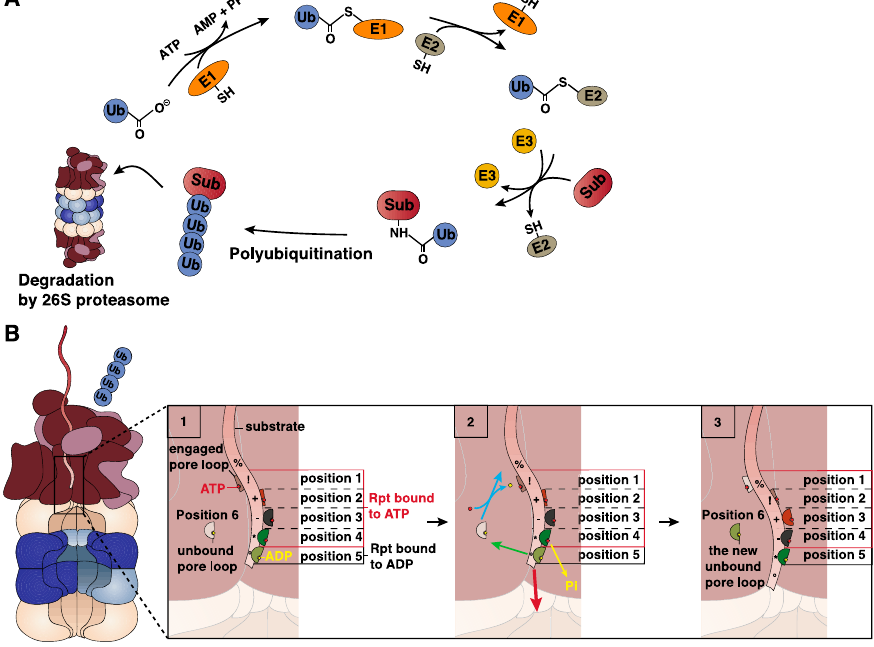
Figure 4. ATP- and ubiquitin-dependent degradation of proteins by the 26S proteasome. ( A ) Ubiquitin conjugation. Ubiquitin (Ub) conjugation requires the activity of three enzymes. E1 (a ubiquitin-activating enzyme) catalyses the ATP-dependent activation of the Ub moiety and its transfer to a conserved active cysteine on E1. Ub is then transferred to an active cysteine on E2 (a ubiquitin-conjugating enzyme). The transfer of the Ub moiety to the substrate requires the activity of an E3 enzyme (a ubiquitin ligase) that can interact with both E2 and the substrate. The resulting product is a protein–ubiquitin conjugate. Finally, the ubiquitin moiety already conjugated to the protein can undergo polymerization by the addition of ubiquitin moieties, forming a suitable tag that allows the targeting of the protein substrate for 26S proteasomal degradation. ( B ) Translocation of the protein substrate into the 26S proteasome. (1) Five of the six pore loops (presented here as half-circles) found in the AAA+ motor of the 19S regulatory particle align in a spiral staircase configuration entrapping the substrate. The four Rpt subunits with the pore loops at the uppermost positions are bound to an ATP molecule (red circle), and the Rpt subunit with the pore loop at the bottom position (position 5) is bound to an ADP molecule (yellow circle). The unbound pore loop occupies position 6 and is not bound to the substrate. (2) First, the Rpt subunit at position 4 hydrolyses the ATP molecule (yellow arrow), and the unbound Rpt subunit binds an ATP molecule. The newly formed Rpt-ATP subunit binds the substrate at the uppermost position as indicated by the light blue arrow, while the pore loop at position 5 disengages the substrate as indicated by the green arrow. Finally, the four Rpt subunits at positions 1–4, which are bound to the protein substrate, move downward, resulting in the translocation of the substrate (red arrow). (3) Following all these changes, the pore loop that was at position 6 occupies the uppermost position (position 1), the pore loop at position 3 occupies the penultimate position (position 4), the pore loop at position 4 occupies the bottom position (position 5), and the Rpt subunit with a pore loop at position 5 dissociates and becomes the new free pore loop at position 6 [104]. Symbols (%, !, +, -, * and °) were added on the protein substrate to aid in visualizing the translocation of the protein. Proteasome Subtypes and the Degradation of Ubiquitinated Proteins Studies have shown that the activity of the 19S RP is rate-limiting in the overall proteolysis of ubiquitinated proteins [112,113]. Indeed, using archaebacterial proteasomes, Benaroudj et al. found that the degradation of unfolded proteins by open- gated 20S proteasome mutants (with α -subunits lacking the N-terminal residues that block the entry of proteins into the 20S complex) was significantly more efficient than the degradation of the same substrates by the WT PAN (equivalent of the eukaryotic 19S